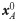
Stimulus generation in MAximum Differentiation (MAD).(a) The MAD concept: given an original image, e.g. the point xA0 in light blue, a perceptual distance measure, , coming from a vision model (leading to the discrimination region in green), and certain fixed Euclidean distance, , (sphere in black); the problem is looking for the best and worst images on the sphere according to the perceptual distance . The solution is given by the images that are in the directions (or paths) leading to the biggest or the lowest perceptual distortions (xMAX0 and xMIN0, in dark blue and orange respectively). In the example, the path leading to the biggest perceptual difference (for the same Euclidean length) is the curve in orange because it represents the shortest path from the original image to the discrimination boundary in green. Equivalently, the path leading to the lowest perceptual difference (for the same Euclidean length) is the curve in blue because it represents the longest path to the discrimination boundary in green. (b) The MAD algorithm: start from a random point at the sphere and modify it to increase (or alternatively decrease) the perceptual distance following . Note that the naive application of the gradient implies a solution out of the sphere. This has to be projected on the sphere through the appropriate correction: first remove the component parallel to , and then project in the direction of . (c) Second order approximation: approximate the perceptual discrimination regions by ellipsoids (local linear approximation of the vision model). In this way the MAD images are given by the directions of the maximum and minimum eigenvalue of the 2nd order metric matrix.